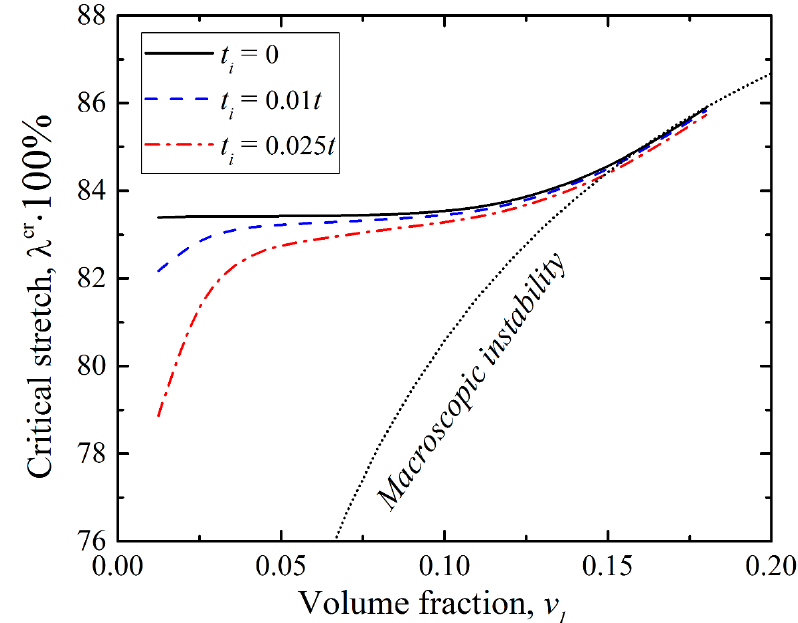
Figure 7. Dependence of the critical stretch ratio λ cr on the volume fraction in the layered composite with µ l / µ m = 15 and shear modulus distribution B. The black dotted curve represents the onset of macroscopic instability in the ideal composites (8).